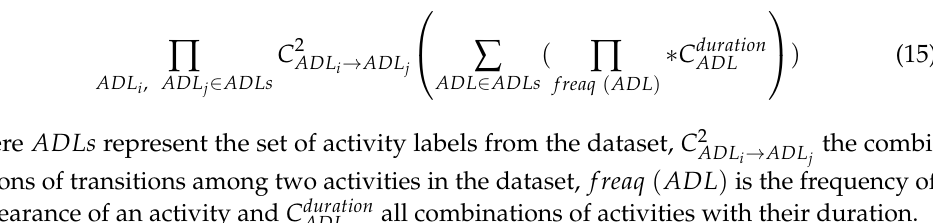
Figure 9. The frequency of occurrence of each ADL per person. Different colors are used for different persons: blue for id = 1, orange for id = 2, gray for id = 3, yellow for id = 4, lilac for id = 5, green for id = 6, red for id = 7, pink id = 8, fuchsia for id = 9, brown for id = 10.